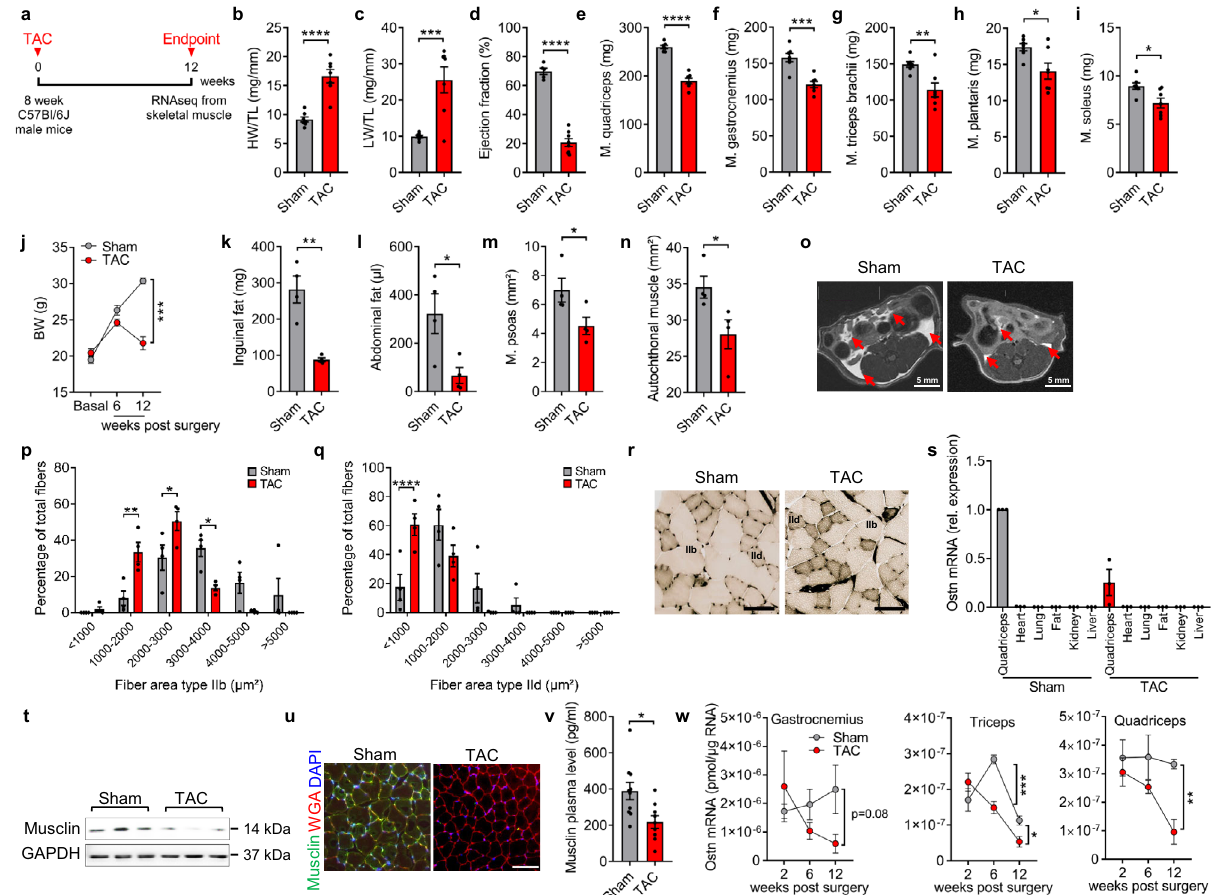
Fig. 1 Musclin expression decreases in wasting skeletal muscles during advanced heart failure. a Scheme depicting the experimental time line. Quanti fi cation of heart weight/tibia length (HW/TL) ratio, n = 7/group, **** p < 0.0001 ( b ), lung weight/tibia length (LW/TL) ratio, n = 7/group, *** p = 0.001 ( c ), left ventricular ejection fraction, n = 5/sham group and n = 8/TAC group, **** p < 0.0001 ( d ), quadriceps muscle weight, n = 7/group, **** p < 0.0001 ( e ), gastrocnemius muscle weight n = 7/group, *** p = 0.0003 ( f ), triceps brachii muscle weight, n = 7/group, ** p = 0.0051 ( g ), plantaris muscle weight, n = 7/group, * p = 0.0175 ( h ), soleus muscle weight, n = 7/group, * p = 0.0126 ( i ), and course of body weight (BW) during the experiment until 12 weeks after TAC or sham surgery, n = 4/sham group and n = 5/TAC group, *** p = 0.0001 ( j ). Inguinal fat weight, ** p = 0.0021 ( k ) in the group of mice that was analyzed by MRI to determine the amount of abdominal fat, * p = 0.0273 ( l ), psoas muscle, * p = 0.0499 ( m ) and autochthonal muscle, * p = 0.0412 ( n ) 12 week after sham or TAC surgery, n = 4/group. Example MRI cross-sections are shown in ( o ). The red arrows indicate abdominal fat. Scale bar: 5 mm. Cross-sectional fi ber area type IIb, ** p = 0.0028 for 1000 – 2000 µ m 2 ; * p = 0.0254 for 2000 – 3000 µ m 2 and * p = 0.0125 for 3000 – 4000 µ m 2 of muscle fi ber area from sham vs. TAC group ( p ), and type IId, **** p < 0.0001 of fi ber area <1000 µ m 2 ( q ) of quadriceps